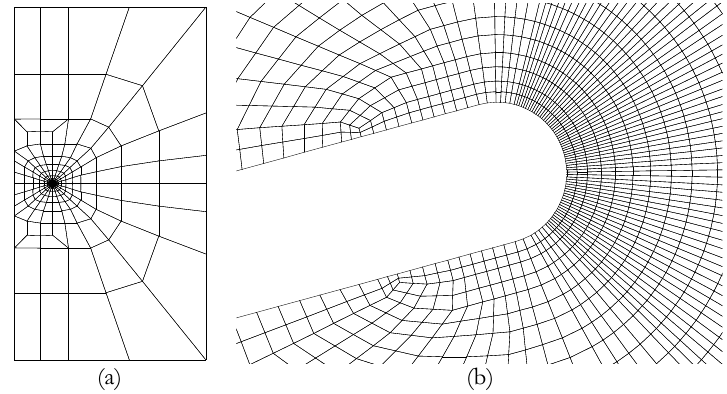
Figure 1: Finite element mesh: (a) general view; (b) crack tip.